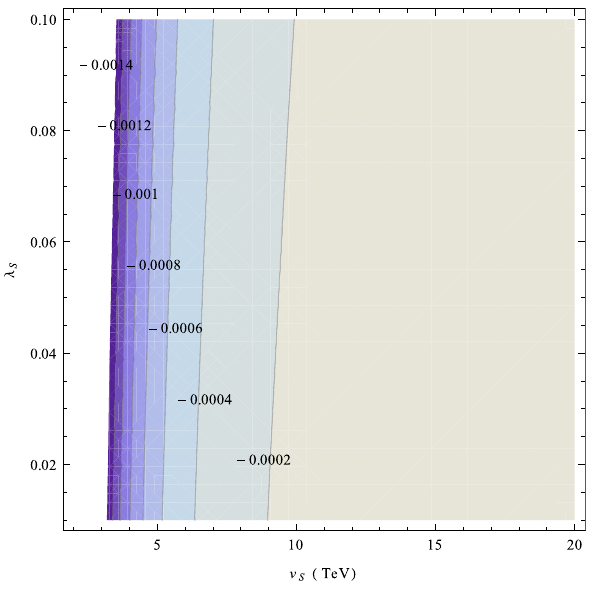
Fig. 2 Variation of λ HS with υ S ( TeV ) and λ S for 0 . 01 ≤ λ S ≤ 0 . 1